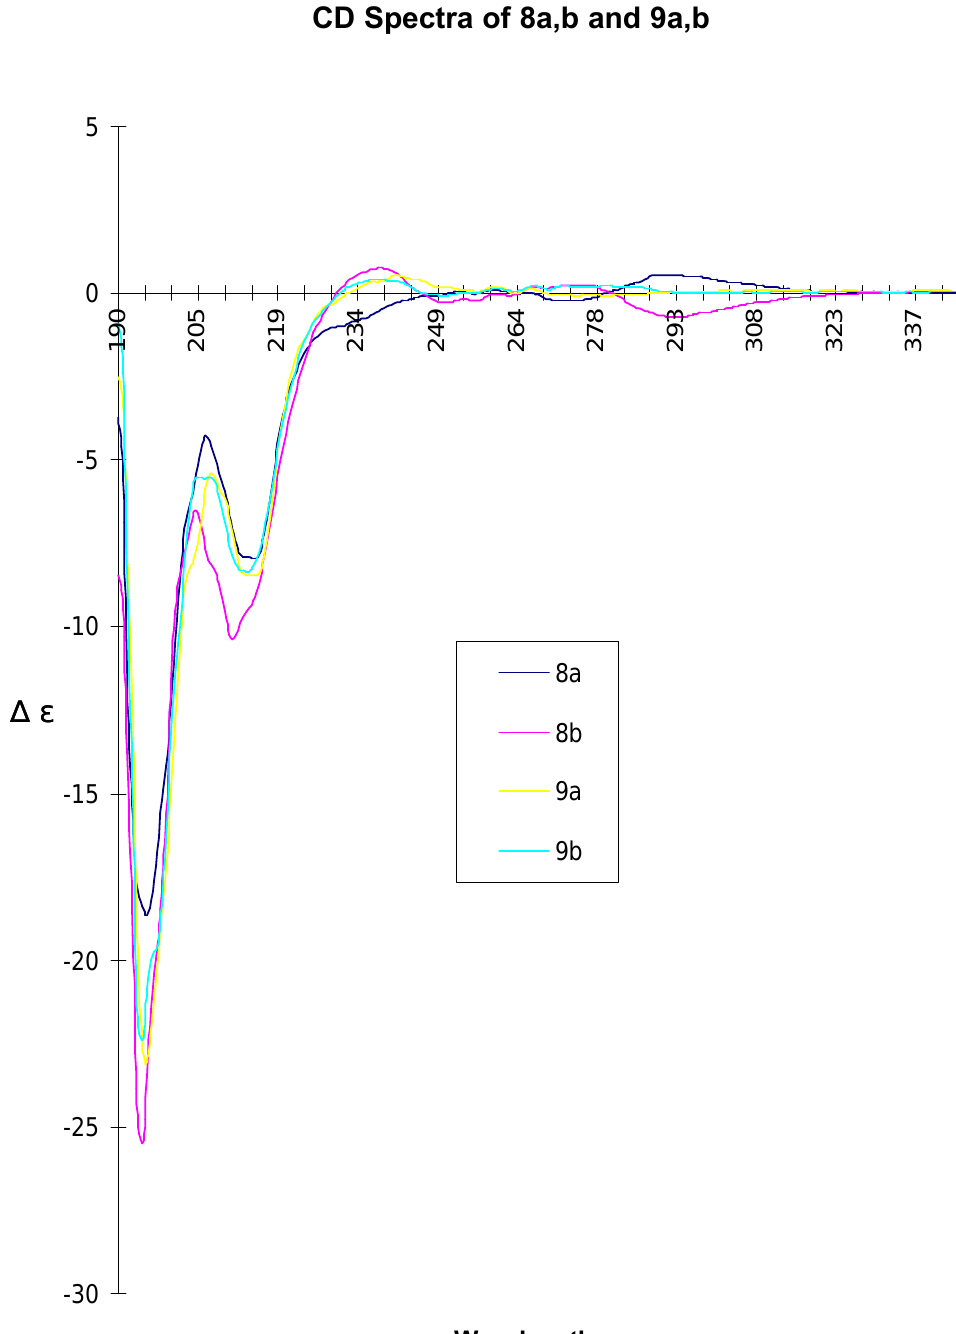
Figure 1. CD Spectra of 8a,b and 9a,b . Conditions: c = 2.00 mg/ml, MeOH, l = 0.01